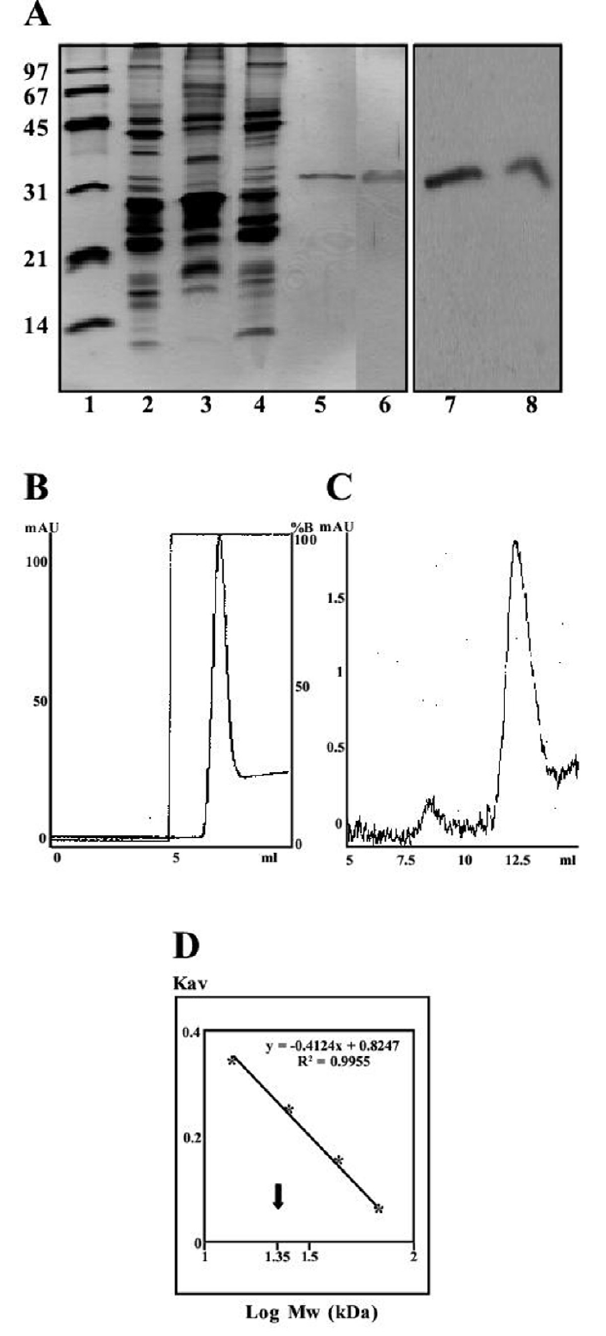
Figure 3 Purification and characterization of lens galectin-3. (A) SDS-PAGE and Western blot documentation of the purification process. Lane 1: Molecular weight markers. Lane 2: Crude lens fiber cell membranes. Lane3 and 4: Insoluble and soluble frac- tions, respectively, after treatment with 20 mM NaOH. Lane 5: Pure galectin-3 eluted from the α -lactose-agarose column with 100 mM lactose. Lane 6: Galectin-3 eluted from a size exclusion chromatography column S-75. Lanes 7 and 8: Immunoblot of the preparations in lanes 4 and 5 identifying galectin-3. (B) Galectin-3 bound to an α -lactose-agarose column, and was eluted with 100 mM lactose. (C) Size exclusion chromatography of the pure galectin-3. The protein was eluted at 12.5 ml. mAU refers to absorbance units at 280 nm (D) Calibration of the S-75 column. Vo = 8.3 ml. Galectin-3 has an apparent molecular mass of 22 kDa